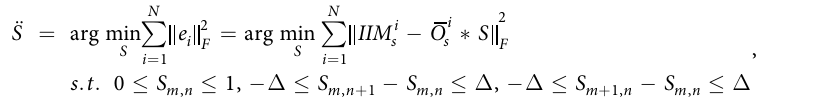
Figure 1. Schematic diagram of data collection. ( a – c ) O si and O respectively. ( d – f ) are the IIMs, corresponding to ( a – c ), respectively, collected by the detector as the laser beam lights through the scattering media with the incident angle θ θ θ = ( , )